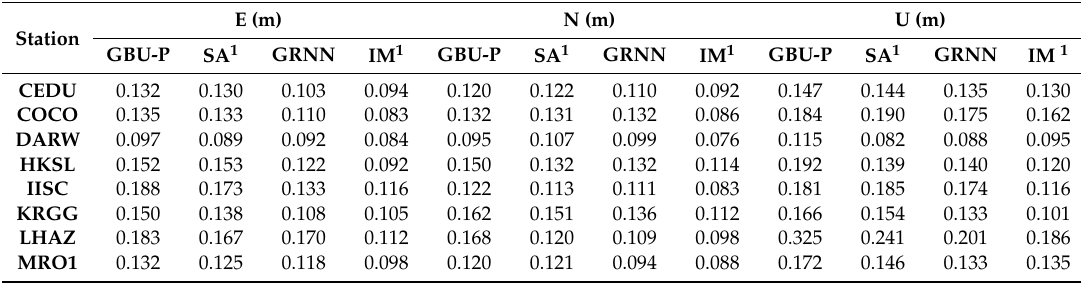
1 : SA means the spectrum analysis model, and IM means the improved